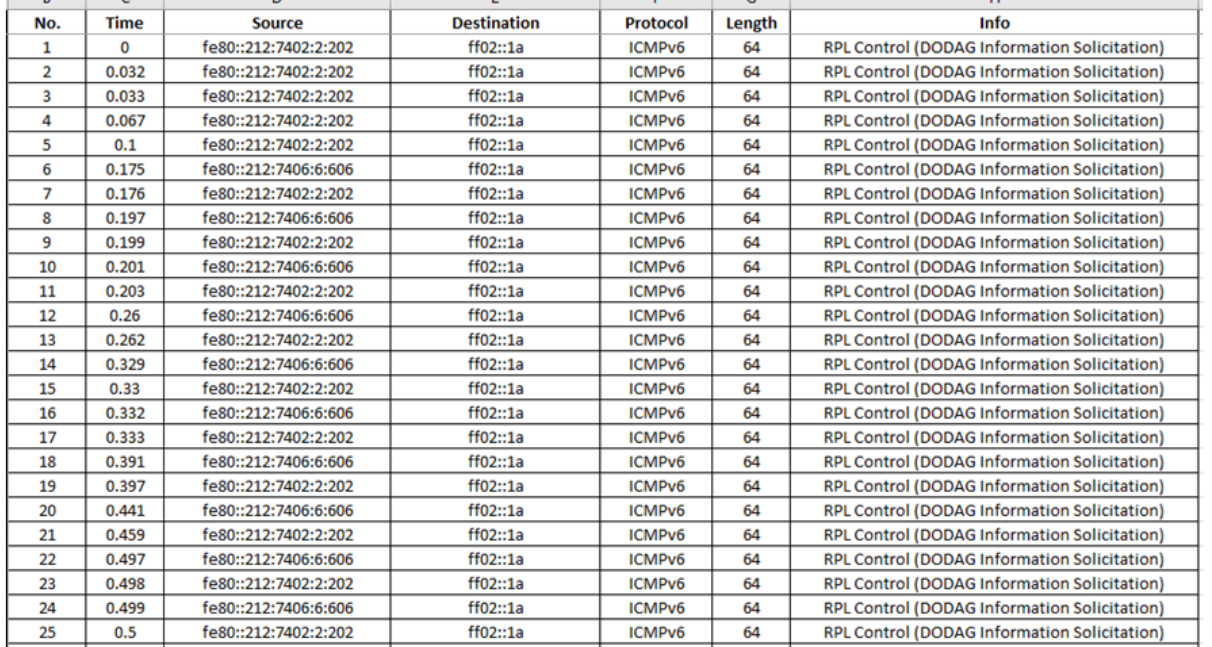
Figure 34. Malicious “radiolog.csv”— 1 to 25 records. “radiologICMPv6.csv”: The generated malicious “radiologICMPv6.csv” file consists